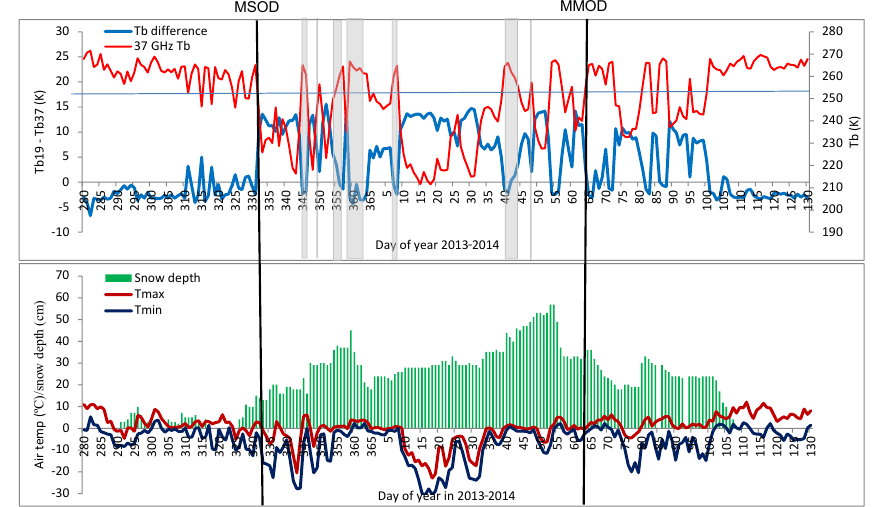
Figure 2. Example of time series of SSM / I T B D (a) and daily surface air temperature ( ◦ C) / snow depth (cm) (b) at Pudasjarvi, Finland (65.4 ◦ N, 26.97 ◦ E) during the 2013–2014 winter. The vertical grey lines/bars in (a) represent melt events detected by